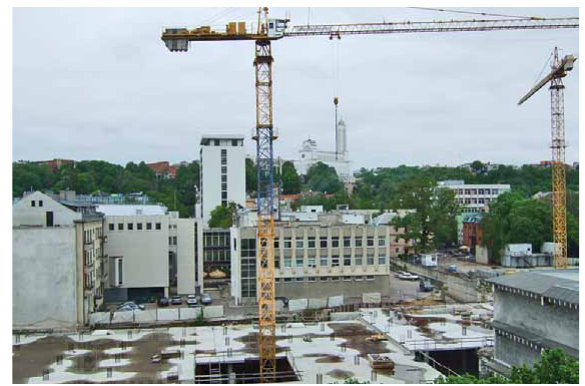
fig. 5. The famous trade house “Merkurijus” (Kaunas) is demolished, but new building is far from